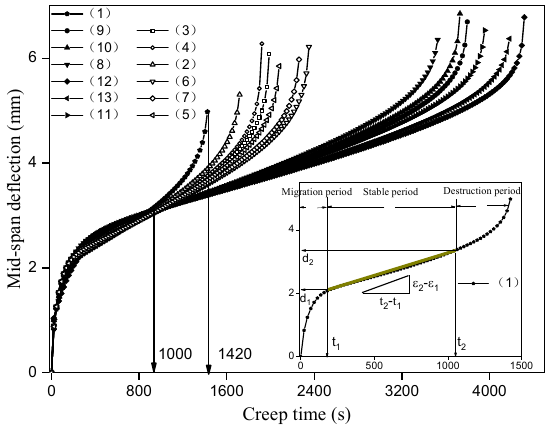
Figure 6. Bending creep test results.